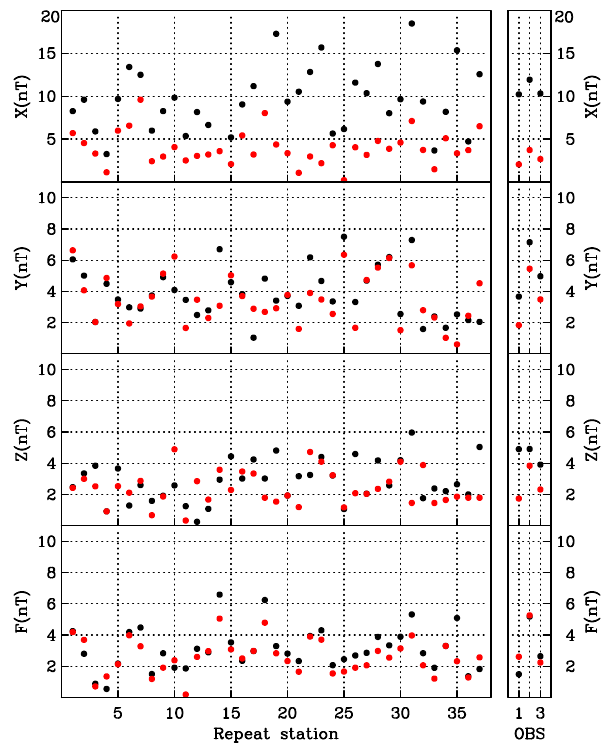
Figure 1. Standard deviation of individual repeat station (left) and observatory (right) lithospheric anomaly estimates around the mean value for southern Africa when only core field model values (black) or core and magnetospheric field model values (red) have been sub- tracted. In a few cases, the difference is so small that the black dot is hidden behind the red one.